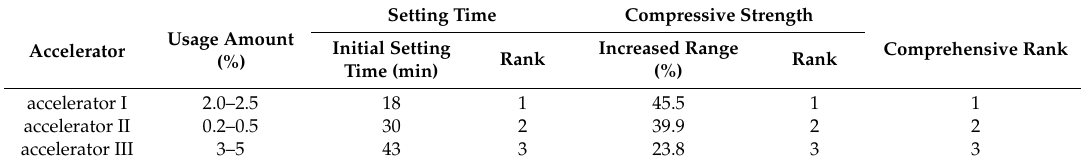
Table 1. Comparison on grouting effect under single use of accelerators.